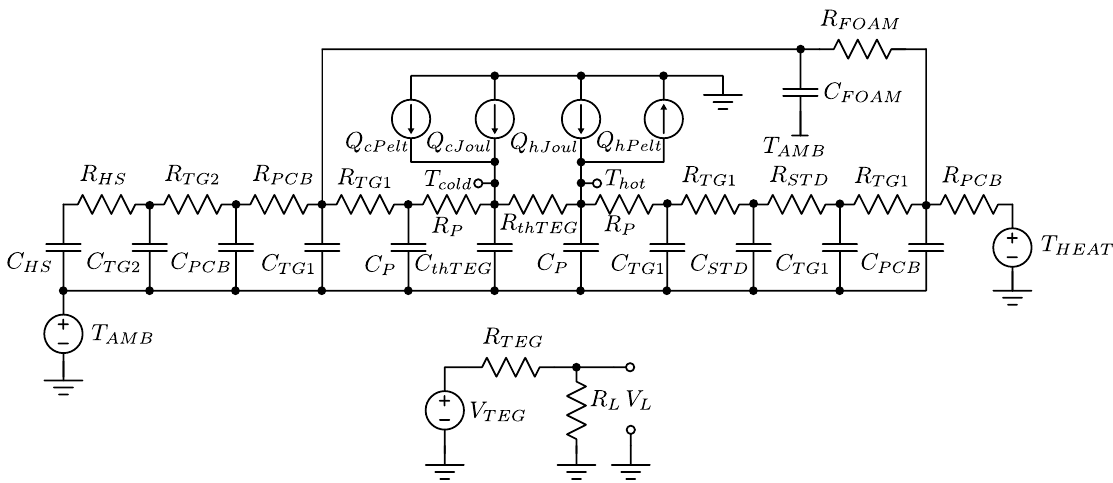
Figure 3. SPICE model of the wireless sensor network node from Figure 1. Table 2. Thermal resistances of the WSN node elements.